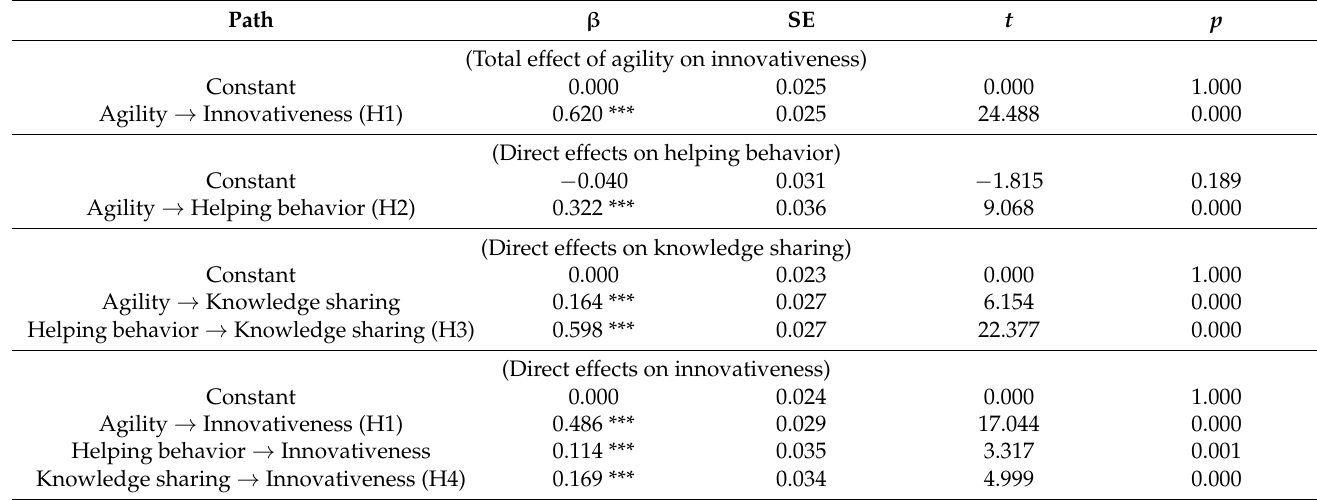
Table 7. Effect by path for non-ICT